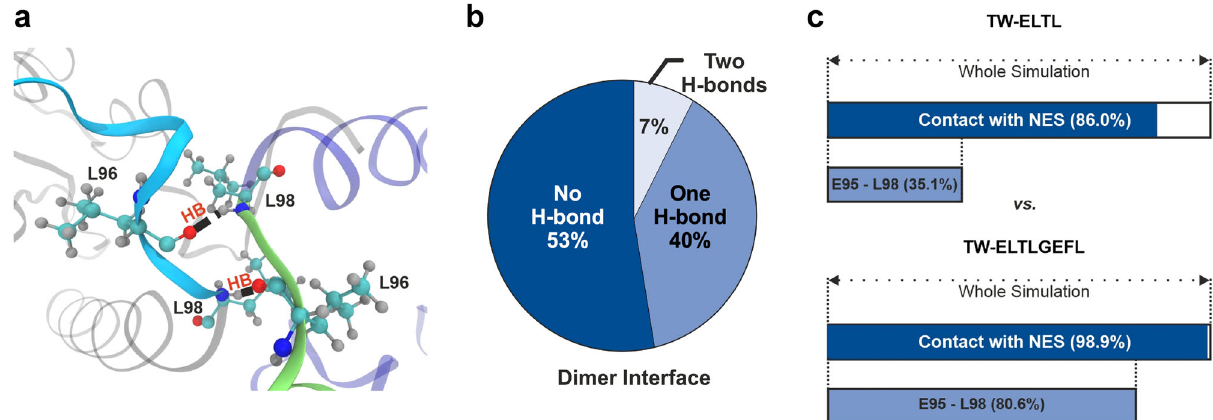
Fig. 5 GaMD simulations and QM/MM calculations on the tweezers – Survivin interaction provide deeper insights into the binding event. a Main hydrogen bonds (HB, red) established between Survivin monomers (gray, violet) at the ELTL interface (contact region of both monomers overlapping with the NES, represented in cyan and green). The leucine residues engaged in these interactions are shown in CPK representation. b Occurrence of hydrogen bonds at the dimer interface. c Frequency of noncovalent contacts between the tweezers, bound to K103, and the NES as well as with the ELTL region ( 95 ELTL 98 ) of the dimer